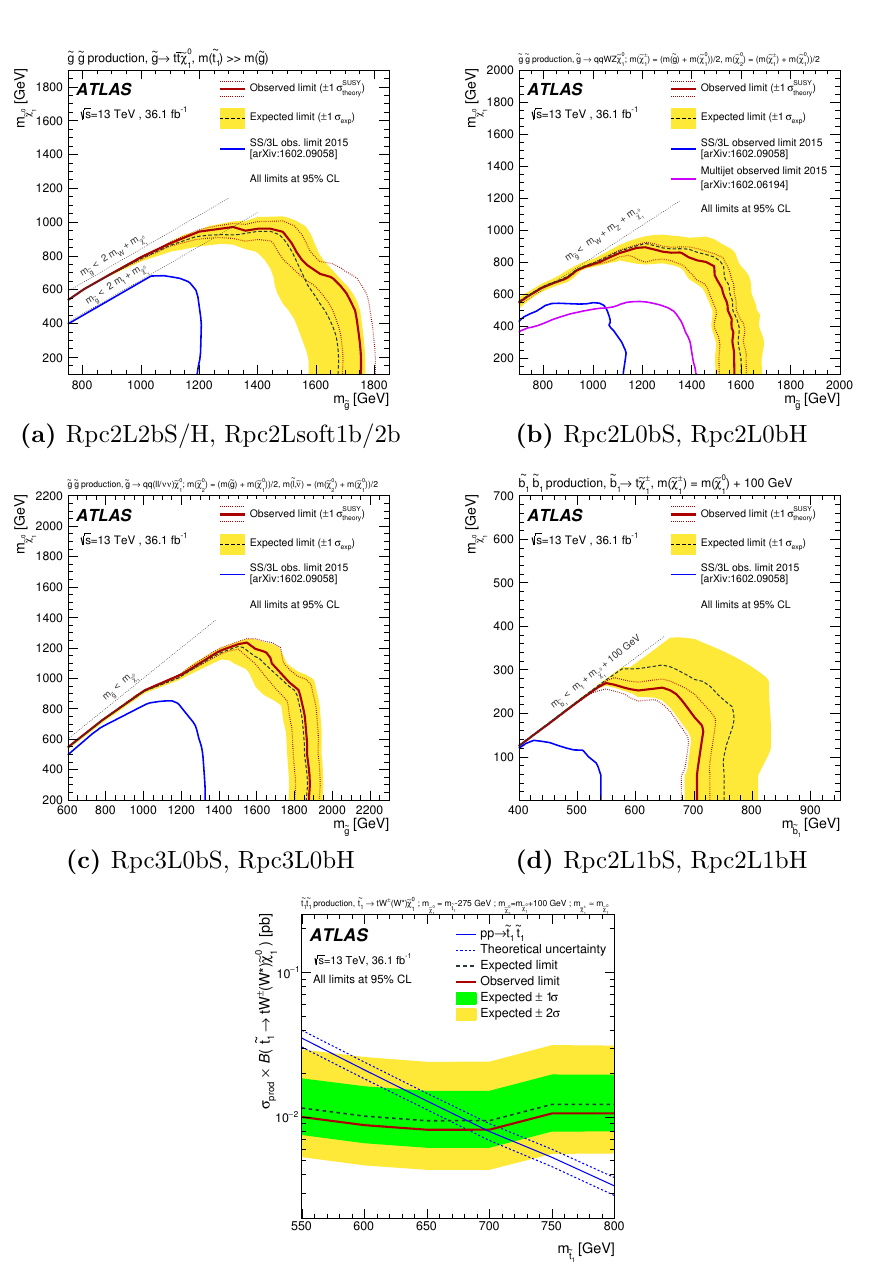
Figure 4. Observed and expected exclusion limits on the ~ g , ~ b , ~ t and ~ (cid:31) 0 1 masses in the context 1 1 of RPC SUSY scenarios with simpli(cid:12)ed mass spectra. The signal regions used to obtain the limits are speci(cid:12)ed in the subtitle of each scenario. All limits are computed at 95% CL. The dotted lines around the observed limit illustrate the change in the observed limit as the nominal signal cross- section is scaled up and down by the theoretical uncertainty. The contours of the band around the expected limit are the (cid:6) 1 (cid:27) results ( (cid:6) 2 (cid:27) is also considered in (cid:12)gure (e), including all uncertainties except the theoretical uncertainties in the signal cross-section. In (cid:12)gures (a){(d), the diagonal line indicates the kinematic limit for the decays in each speci(cid:12)ed scenario and results are compared with the observed limits obtained by previous ATLAS searches [23,